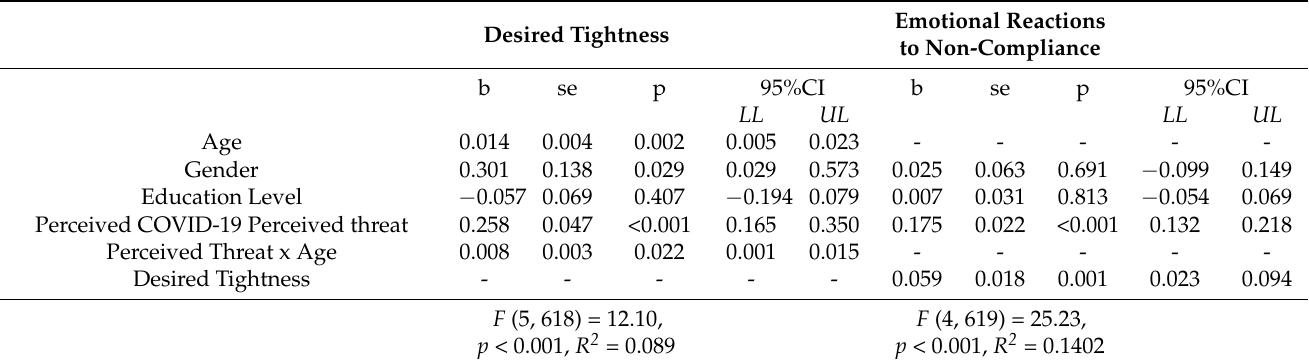
Table 4. Moderated mediation